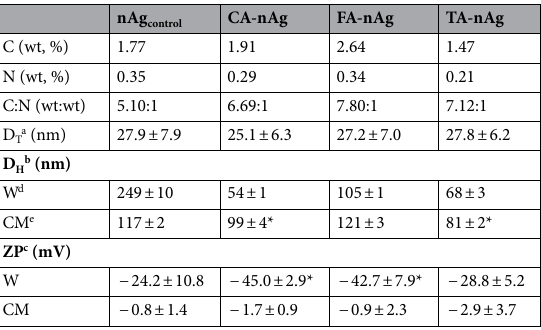
Table 1. Physicochemical properties of AgNPs. a Diameter of AgNPs confirmed by TEM (count from 200 particles). b Zeta-potential value. c Hydrodynamic diameter of AgNPs in solution. d Water. e Culture medium supported with 1% FBS. *Signed to the significant difference from control (p < 0.05).